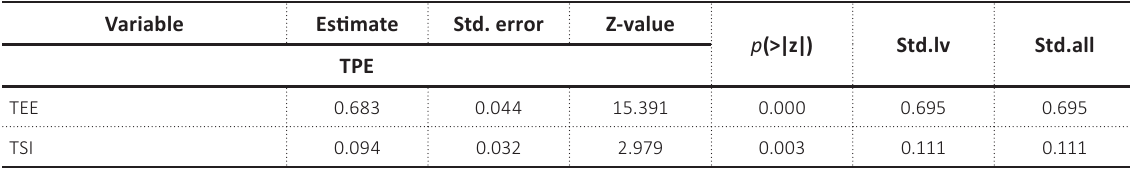
Table 7. SEM when estimating ML – Overview of results for a structural regression model